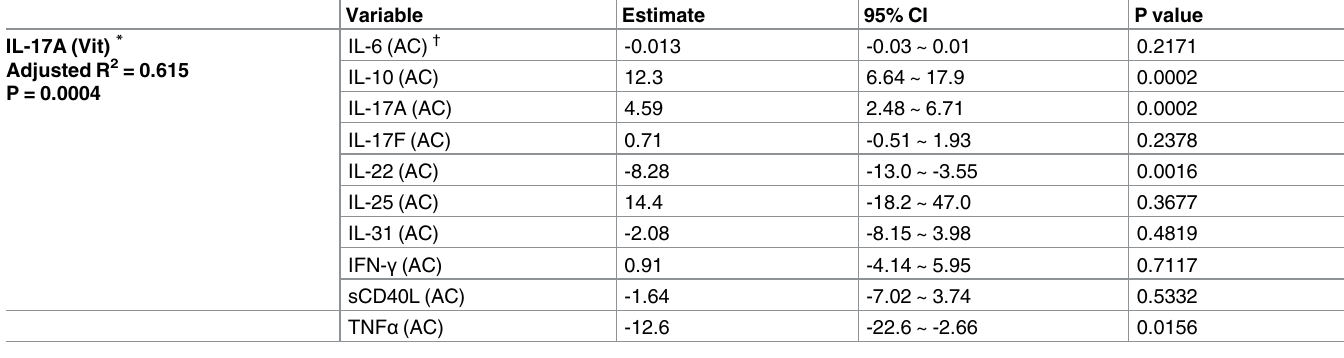
Table 3. Multiple regression analysis of IL-17A level in vitreous fluid with cytokine levels in aqueous humor of patients with proliferative diabetic retinopathy (PDR). Variable